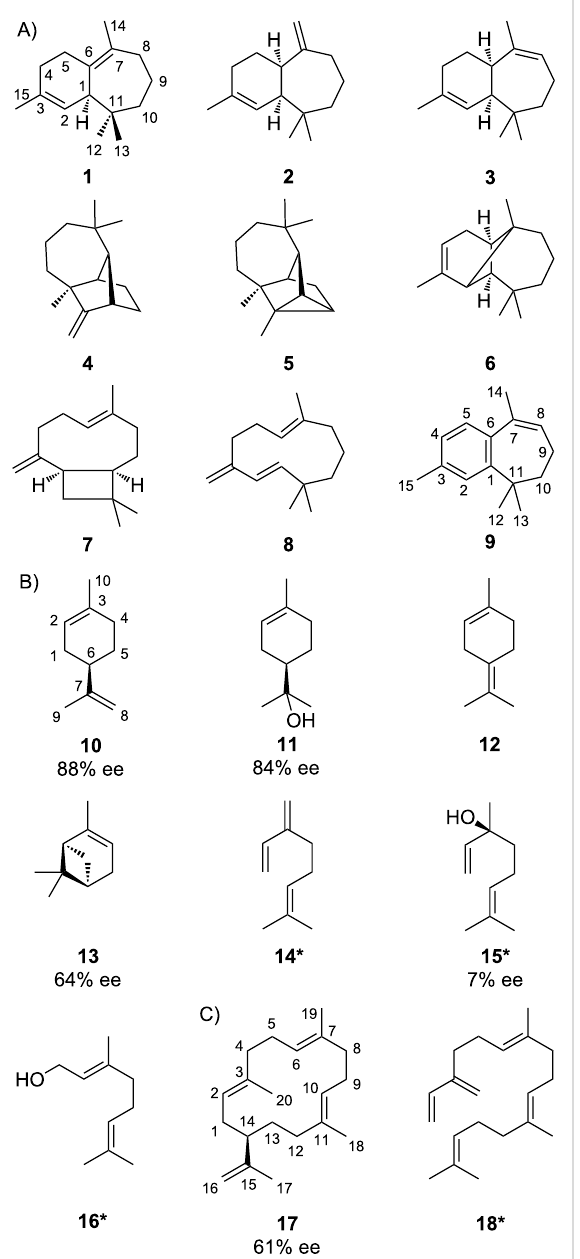
Figure 2: Structures of HcS products arising A) from FPP together with related oxidation product 9 , B) from GPP and C) from GGPP. The carbon numberings of 1 and 9 refer to the carbon positions of FPP as shown in Scheme 3, numberings of 10 and 17 are derived from that of GPP and GGPP, respectively. Compounds known to also originate from non-enzymatic hydrolysis are labelled with an asterisk. The enan- tiomeric excess values were determined based on GC analysis on a chiral phase.